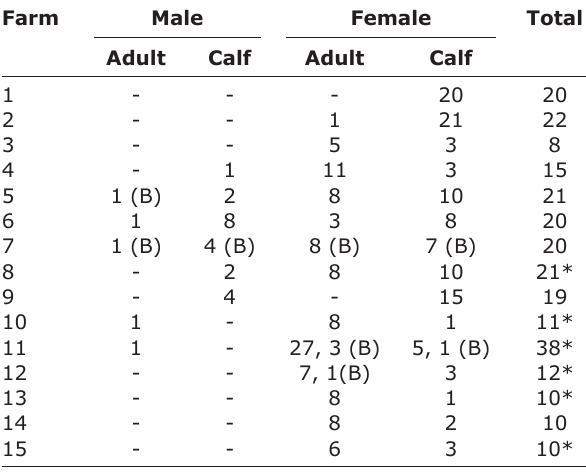
Table-1: Details of rectal swabs collection from different farms in and around Pune,